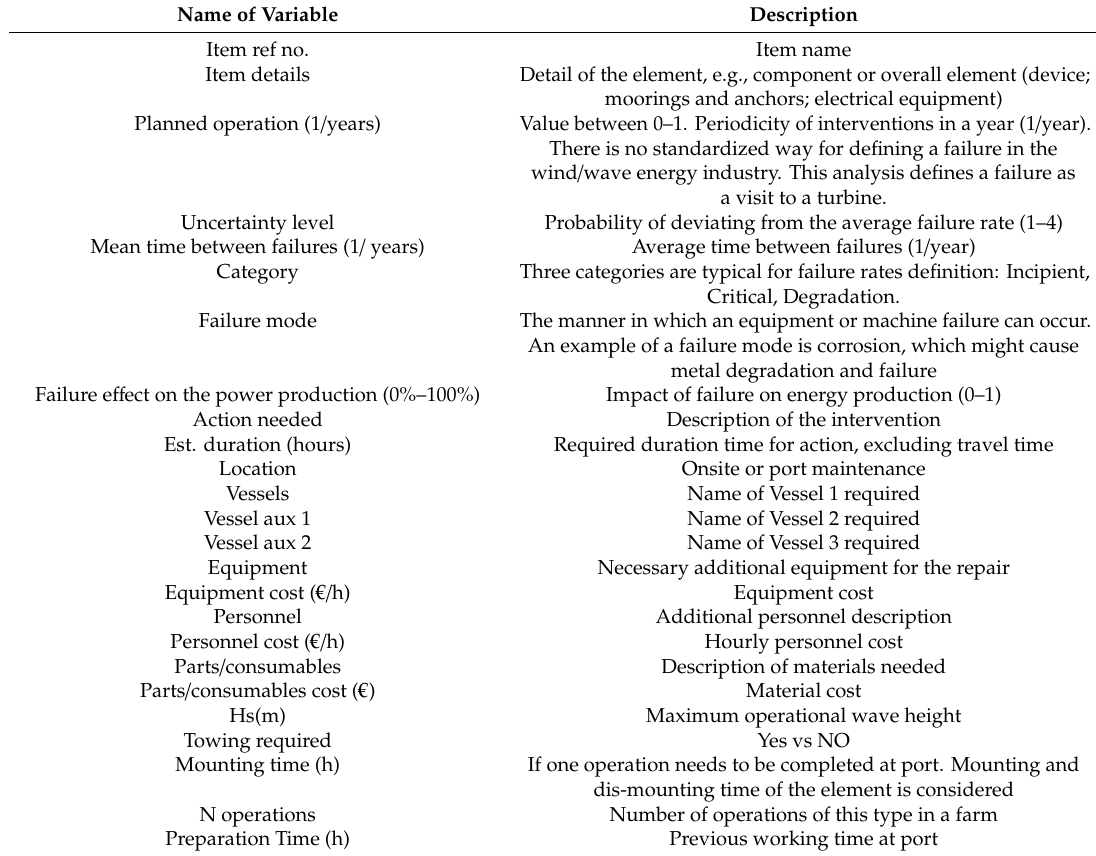
Table 2. Description of Input